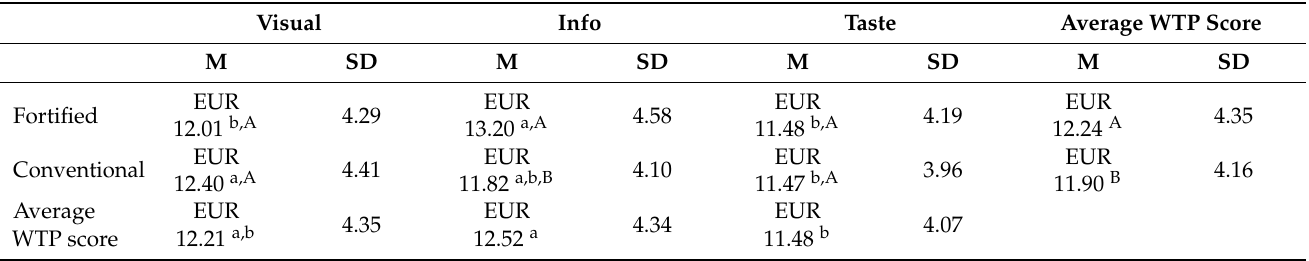
Table 6. Overall WTP for fortified/conventional fish according to the stage of detection in the first experimental condition (visual, information, and taste) 1